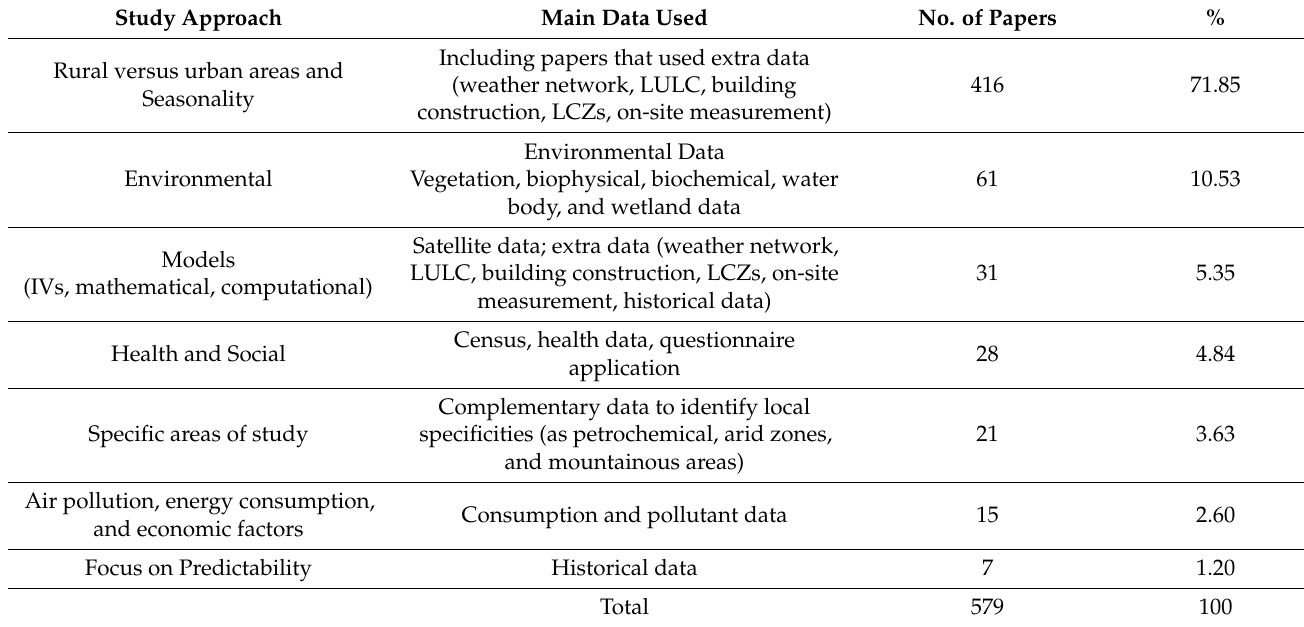
Table 5. Study of the UHI